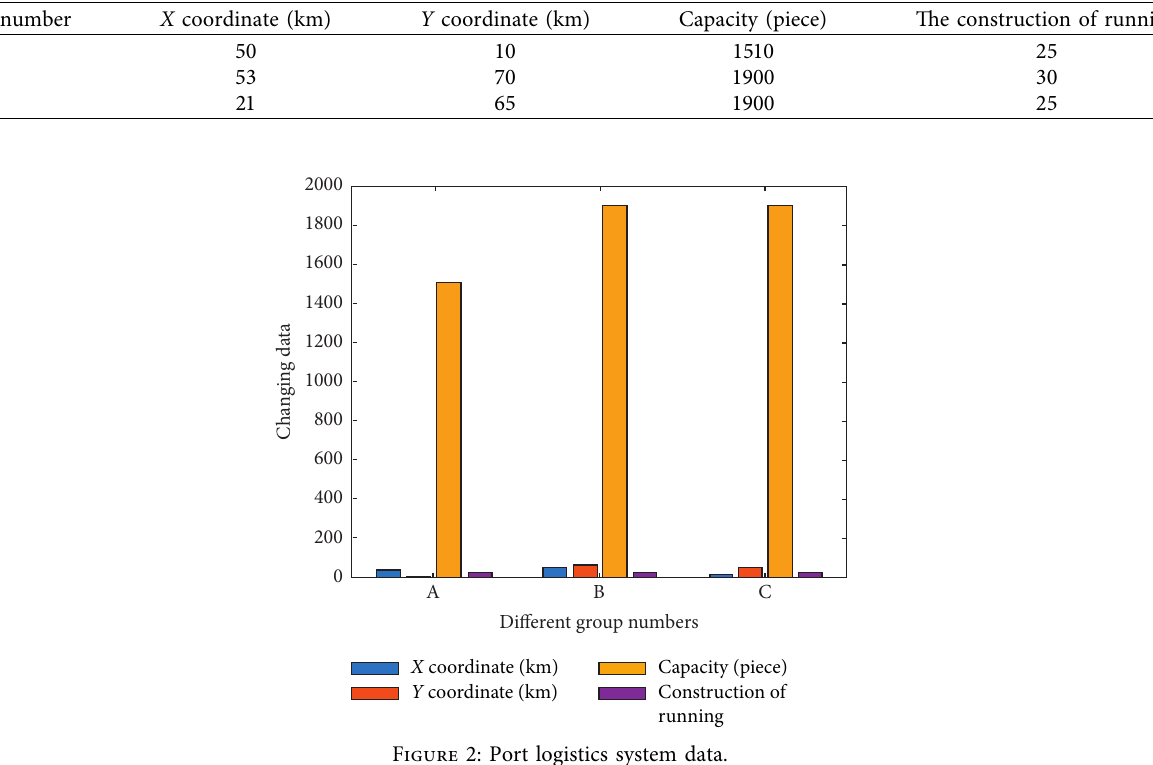
Table 1: Port logistics system data.